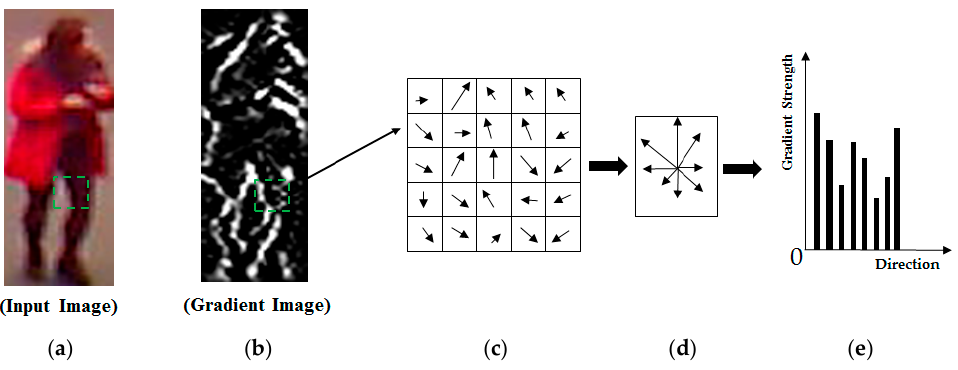
Figure 2. Methodology of image features extraction using the histogram of oriented gradients (HOG) method: ( a ) input image with a given sub-block; ( b ) the gradient image of ( a ); ( c ) the gradient map of the green sub-block in ( a , b ); ( d ) the accumulated strength and direction information of the gradient at every pixel in the green sub-block; and ( e ) the final extracted feature for the green sub-block. In order to extract the image features from an entire image, the image is first divided into n ( n =